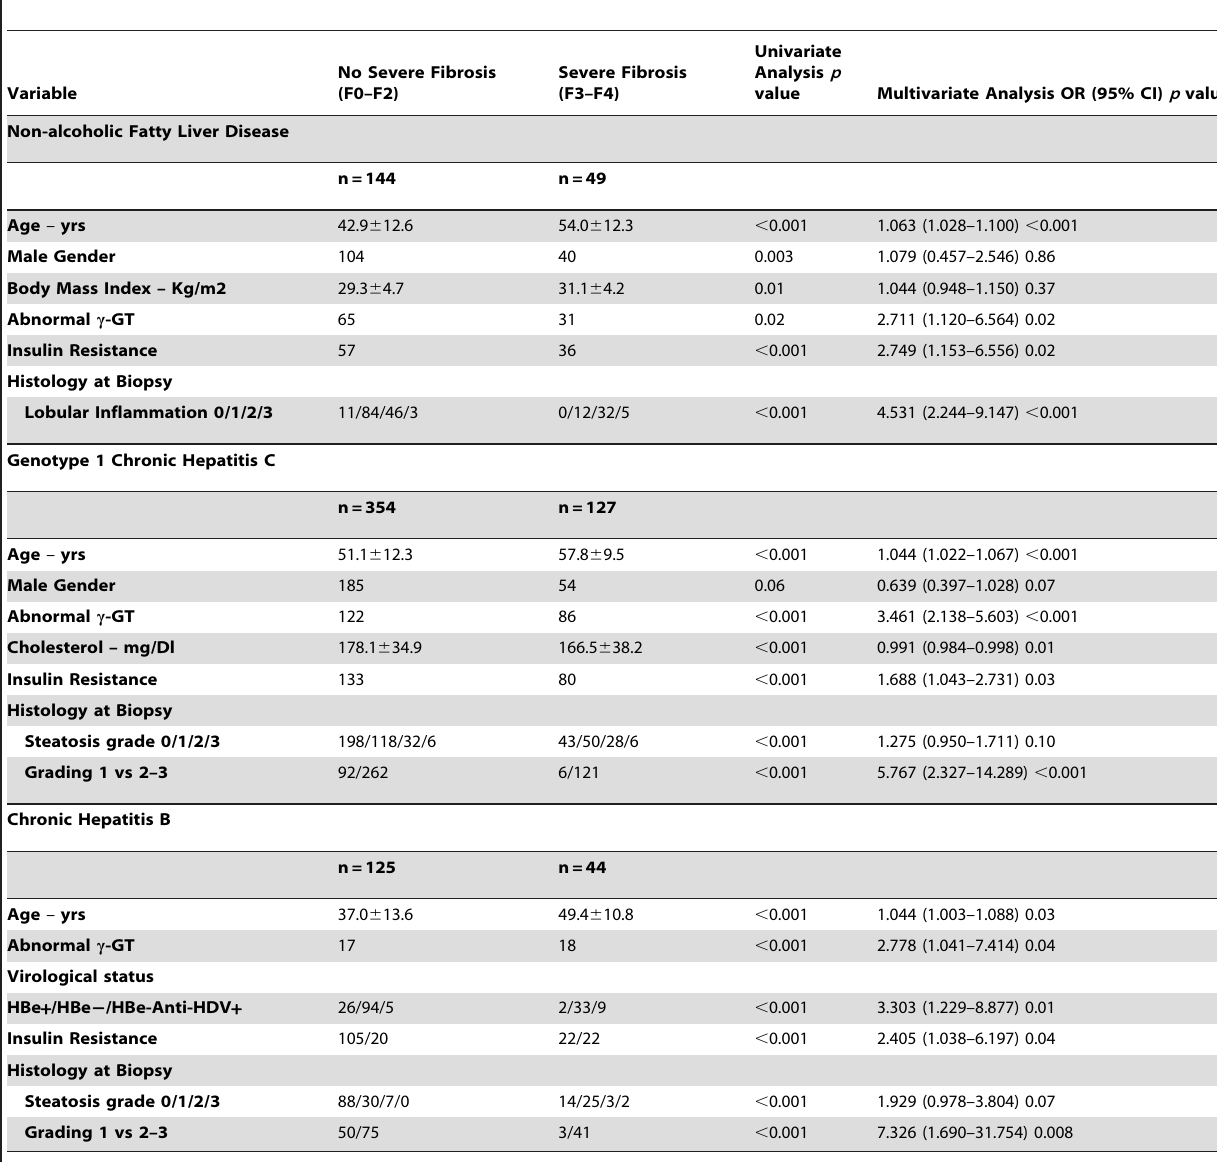
Table 2. Univariate and Multivariate Analysis of Risk Factors Associated with Severe Fibrosis (F3–F4) in 843 Patients with Metabolic and Viral Chronic Liver Diseases by Logistic Regression